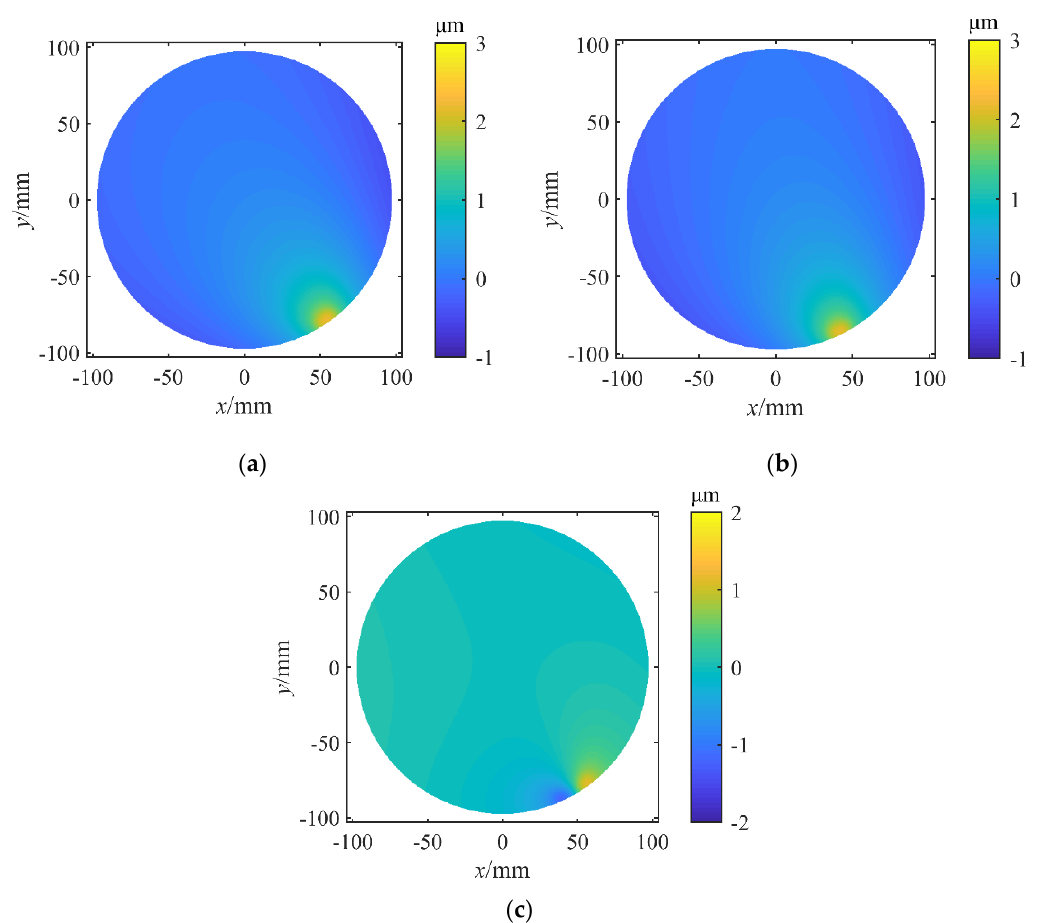
Figure 9. Wafer deformations under unit stress load on one subarea ( a ), its adjacent subarea ( b ), and their difference ( c ) when the number of subareas was